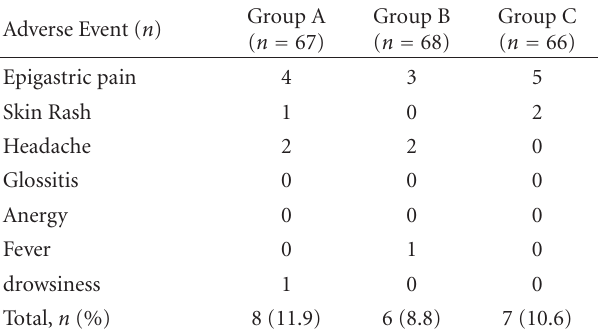
Table 3: Patients with self-reported adverse events during therapy. Adverse Event ( n